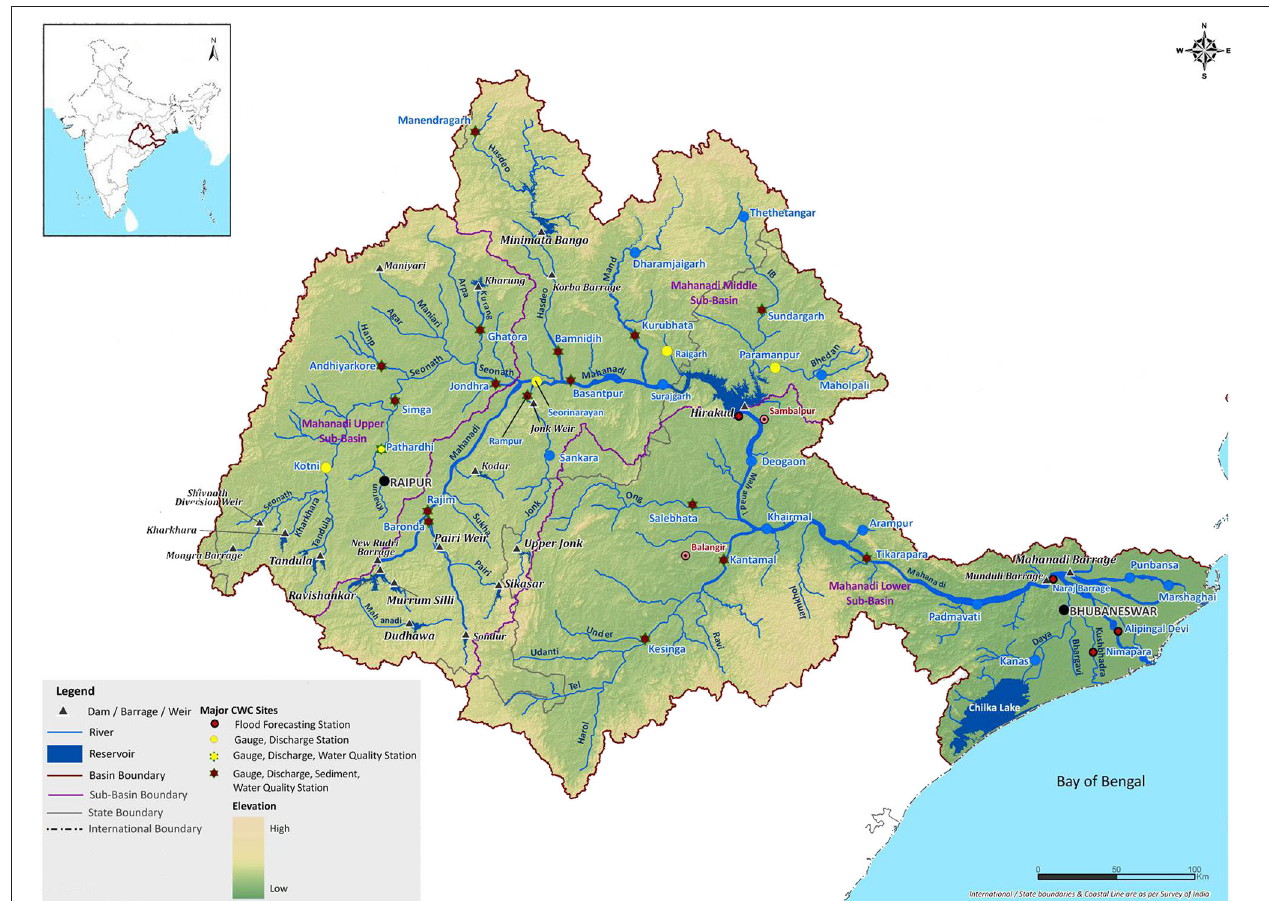
FIGURE 1 | Drainage -basins of Mahanadi River. Source: CWC and NRSC